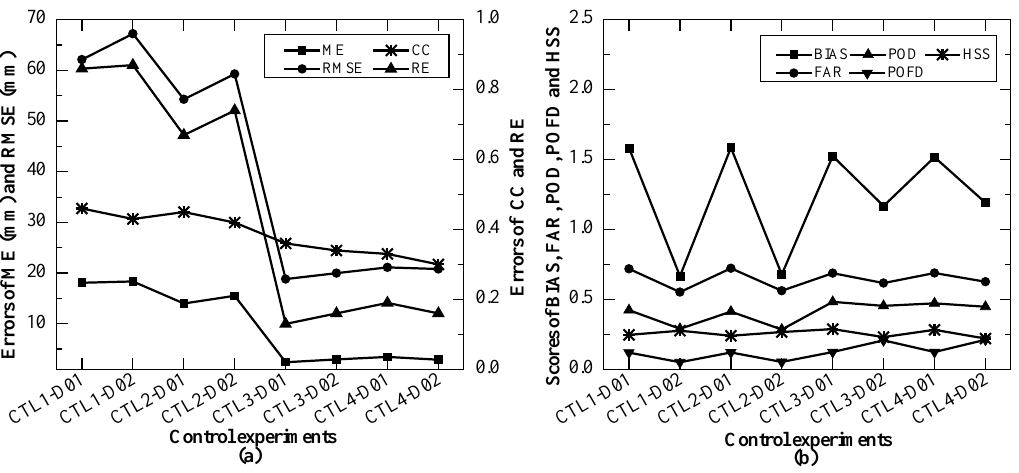
Figure 9. ( a ) Error indices for daily precipitation between the CTL experiment simulations and the CMA observations; ( b ) skill score averages of hourly precipitation between the CTL experiment simulations and the merged CMORPH estimations.